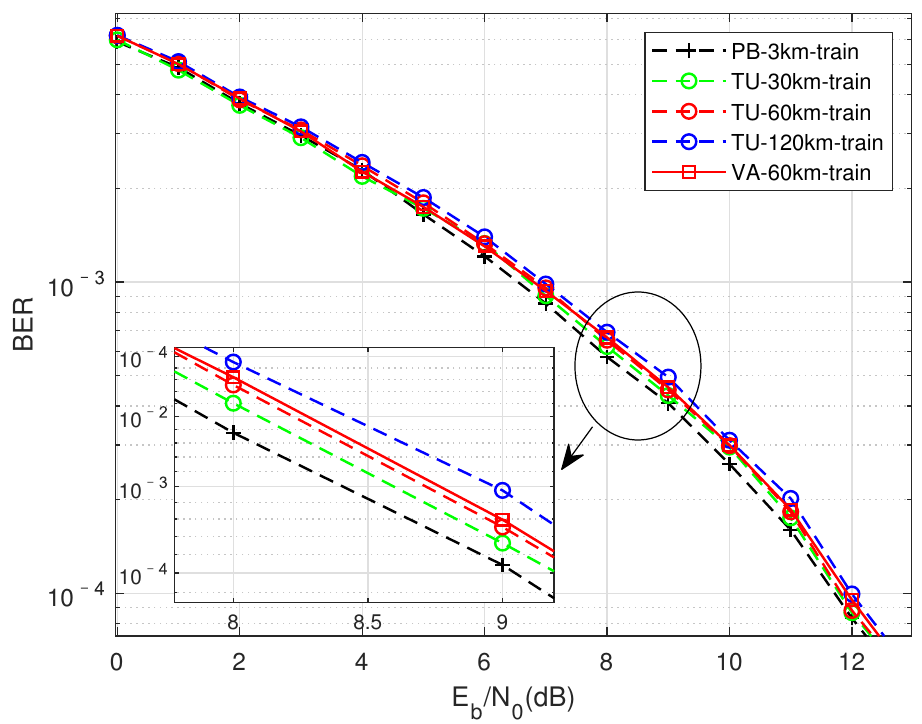
Figure 11. Perform training in different channel environments under the condition of matching signal- to-noise ratio, test with PB-3 km/h, performance under the condition of compression factor τ =